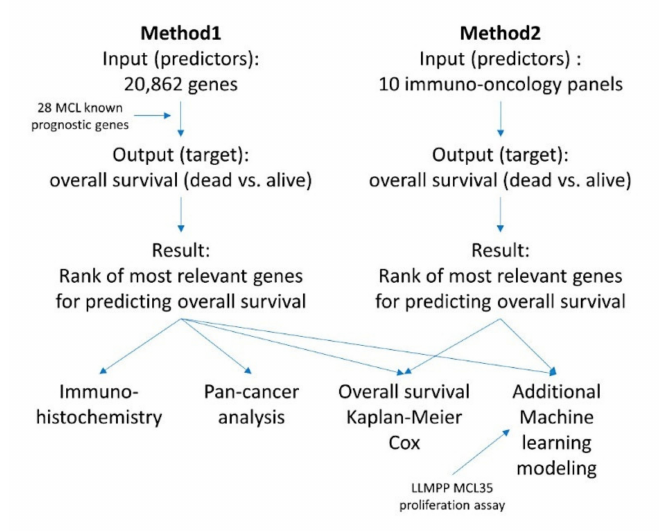
Figure 4. Summary of the analysis methodology. The analysis was comprised of two methods, one based on the analysis of 20,862 genes and a second based on 10 immuno-oncology panels. This research used artificial neural networks and several machine learning techniques to identify genes associated with the overall survival of the patients. Correlation with known MCL pathogenic genes and the LLMPP MCL35 proliferation assay was also